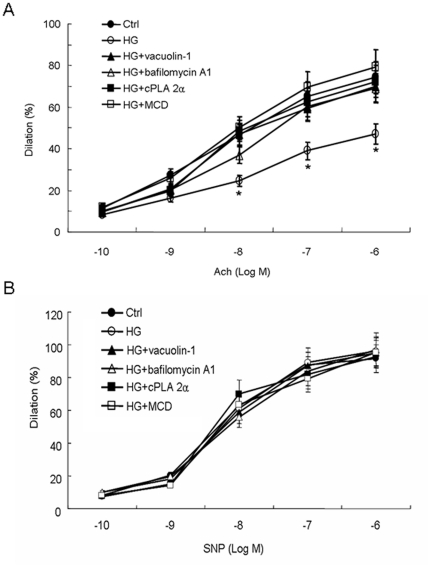
Effect of normal (5.6 mmol/l, Ctrl) or high glucose (22 mmol/l, HG) incubation with or without pretreatment by lysosomal inhibitors or MCD (10 mmol/l for 1 h) on acetylcholine (Ach)-induced NO-mediated endothelium-dependent vasodilation (A) or sodium nitroprusside (SNP)-induced endothelium-independent vasodilation (B) in isolated rat abdominal aortas.Ach-induced NO-mediated endothelium-dependent vasodilation was impaired significantly by HG incubation (open circles) at Ach concentration of 10−8 mol/l, 10−7 mol/l and 10−6 mol/l as compared with Ctrl (black circles), and the effect was restored by pretreatment of vacuolin-1 (black triangles), bafilomycin A1 (open triangles), cPLA 2α (black squares) or MCD (open squares). SNP-induced NO-mediated endothelium-independent vasorelaxation did not differ among groups including Ctrl, HG, and HG with pretreatments mentioned above. Values are means±SE; n = 5 times of assay. * P<0.05 vs. Ctrl at the same concentration of Ach.